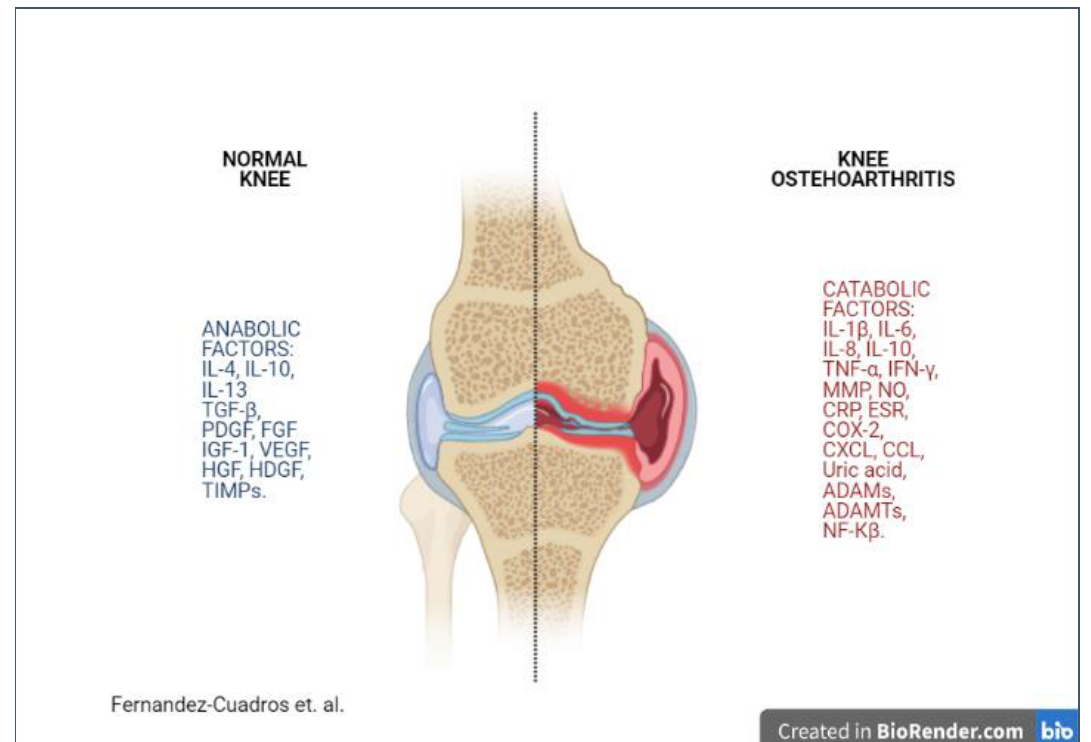
Figure 1. Osteoarthritis is the result of an imbalance between anabolic and catabolic factors where pro-inflammatory cytokines and catabolic chemokines predominates over anti-inflammatory cytokines and anabolic chemokines (Fernandez-Cuadros et al. [5]). Legend: MMP, matrix mineral metallopro- teases. ADAMs, disintegrin and metalloprotease. ADAMTS, disintegrin and metalloprotease with thrombospondin motifs. NO, nitric oxide. TNF- α , tumor necrosis factor α ; iNOS, Inducible Nitric Oxide Synthase. COX-2, cyclooxygenase-2. CXCL, chemokine receptor. CCL, chemokine ligand. CRP, C-reactive protein. ESR, erythrocyte sedimentation rate. TGF- β , transforming growth factor β . HGF, hepatocyte growth factor. VEGF, vascular endothelial growth factor. EGF, endothelial growth factor. IGF-1, insulin growing factor 1. HDGF, hepatocyte derived growth factor. TIMPS, Tissue inhibitor